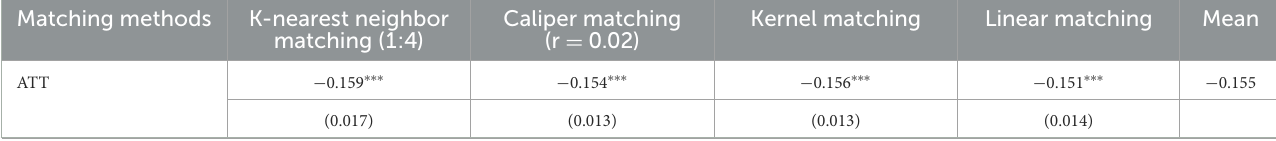
TABLE 5 Robustness tests and regression results for the introduction of instrumental variables.